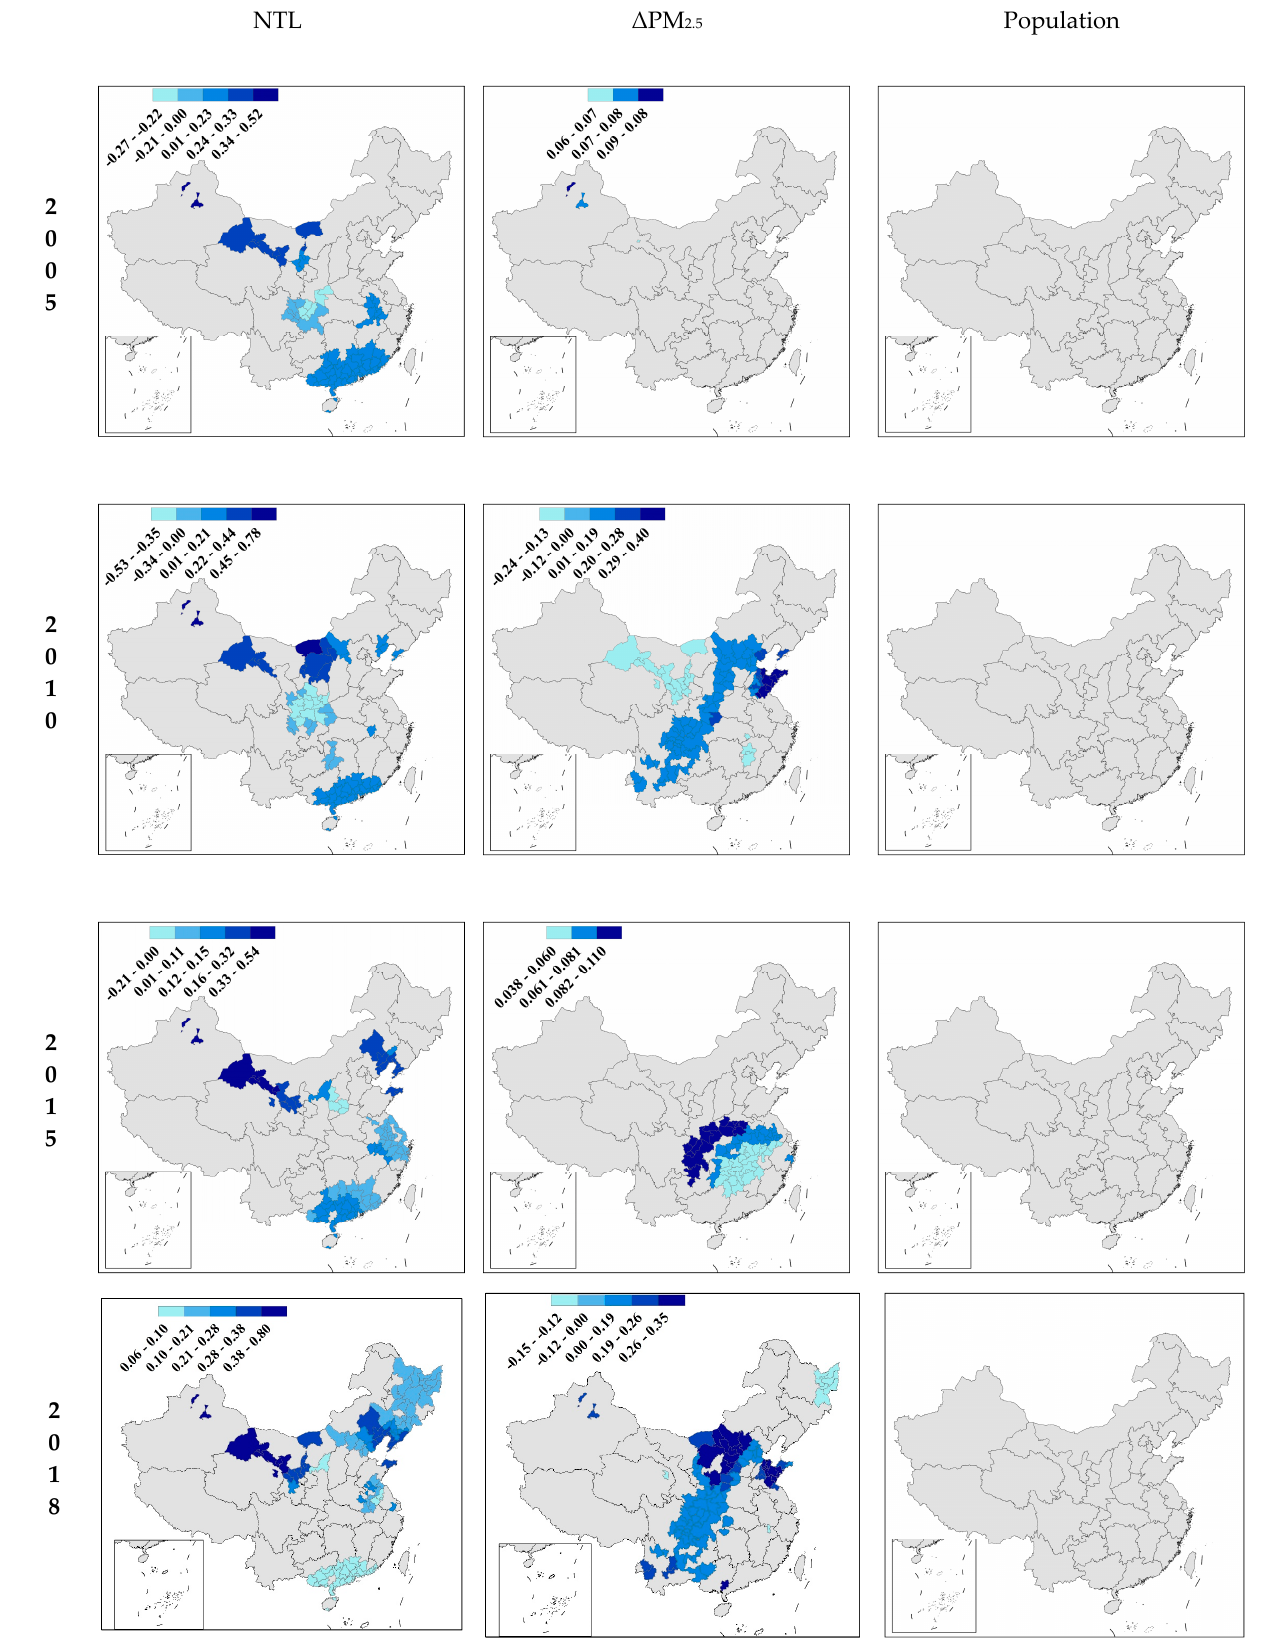
Figure 7. Spatial distributions of the coefficients of NTL, ∆ PM 2.5 , and Population for the daytime MGWR model in in 2005, 2010, 2015, and 2018.